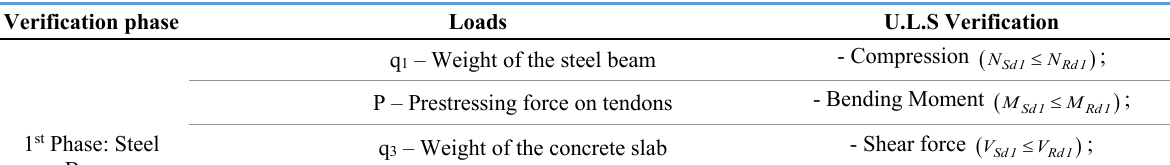
Table 3. Design verifications of prestressed steel-concrete composite beam – ULS.